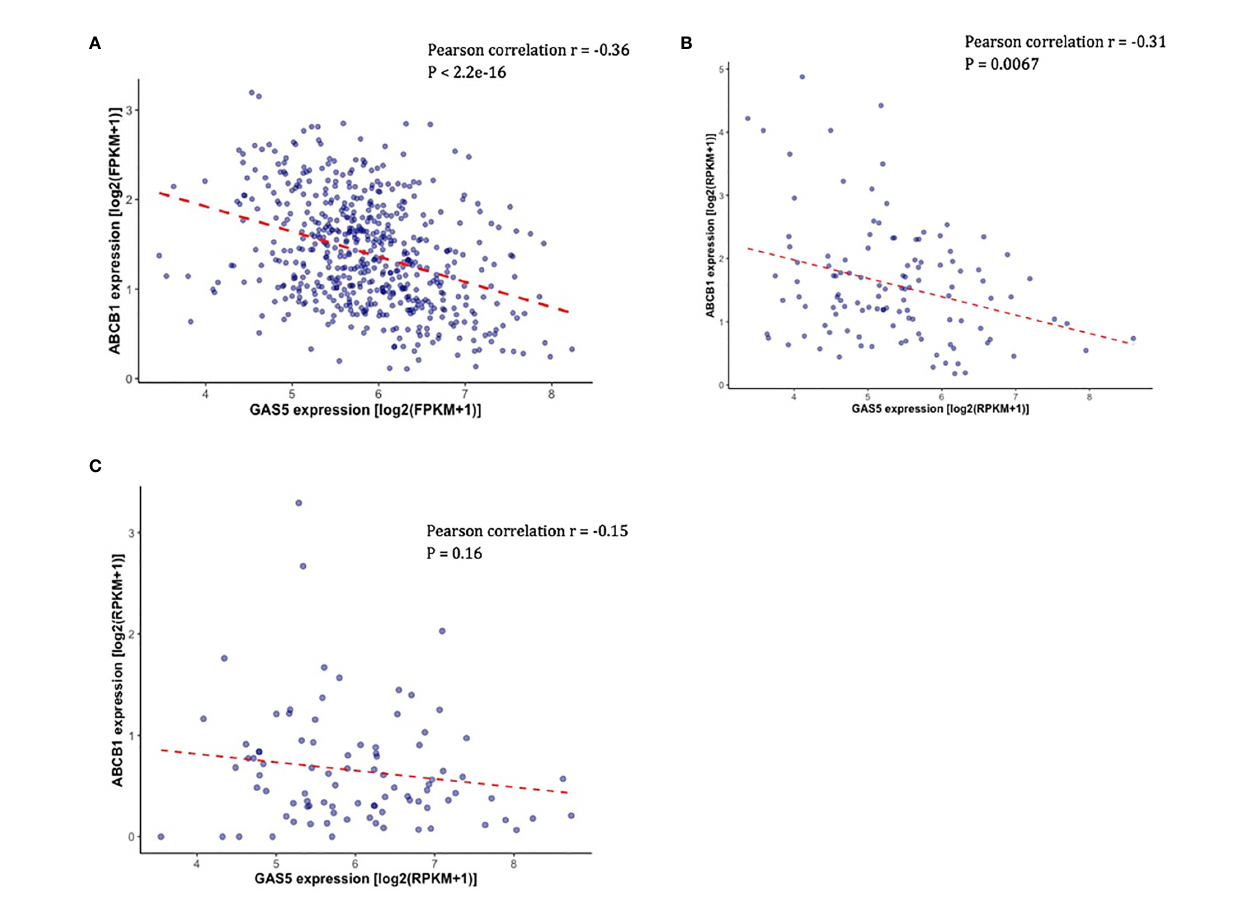
FIGURE 3 | Validation of the correlation between the expression of GAS5 and the expression of ABCB1 in PCa patient datasets. (A) Scatter plot showing the expression level of ABCB1 (Y-axis) and the expression level of GAS5 in PCa patients in TCGA. (B) Scatter plot showing the expression level of ABCB1 (Y-axis) and the expression level of GAS5 in PCa patients in SU2C. (C) Scatter plot showing the expression level of ABCB1 (Y-axis) and the expression level of GAS5 in PCa patients in PRMOTE.